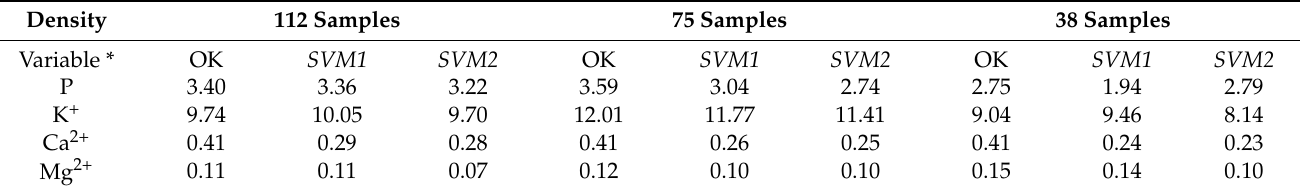
Table 2. RMSE values found for P, K + , Ca 2+ , and Mg 2+ for the sampling grids with grid of 38, 75, and Table 3. RMSE values found for P, K + , Ca 2+ , and Mg 2+ for sampling grids with density of 112, 75, 112 sampling points for the training set. and 38 sampling points for the test